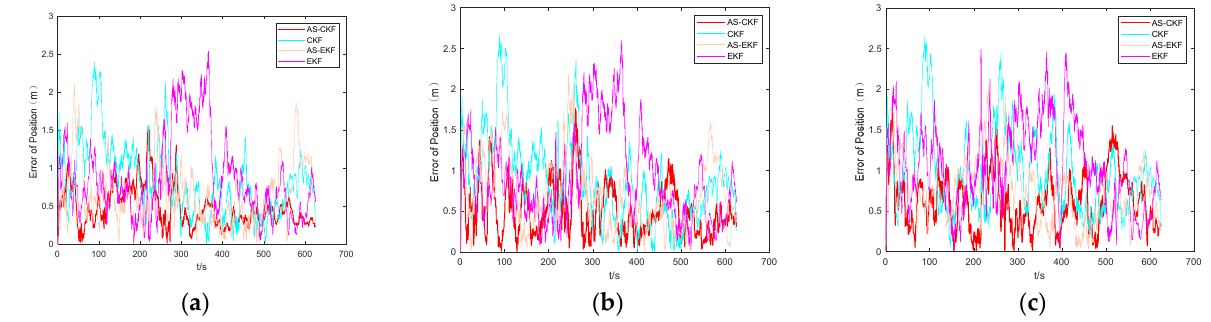
Figure 11. Position error comparison of AS ‐ CKF, CKF, AS ‐ EKF, and EKF estimation in delayed time: ( a ) represents the time delay τ = 20 ms, ( b ) represents the time delay τ = 40 ms, and ( c ) represents the time delay τ = 100 ms.